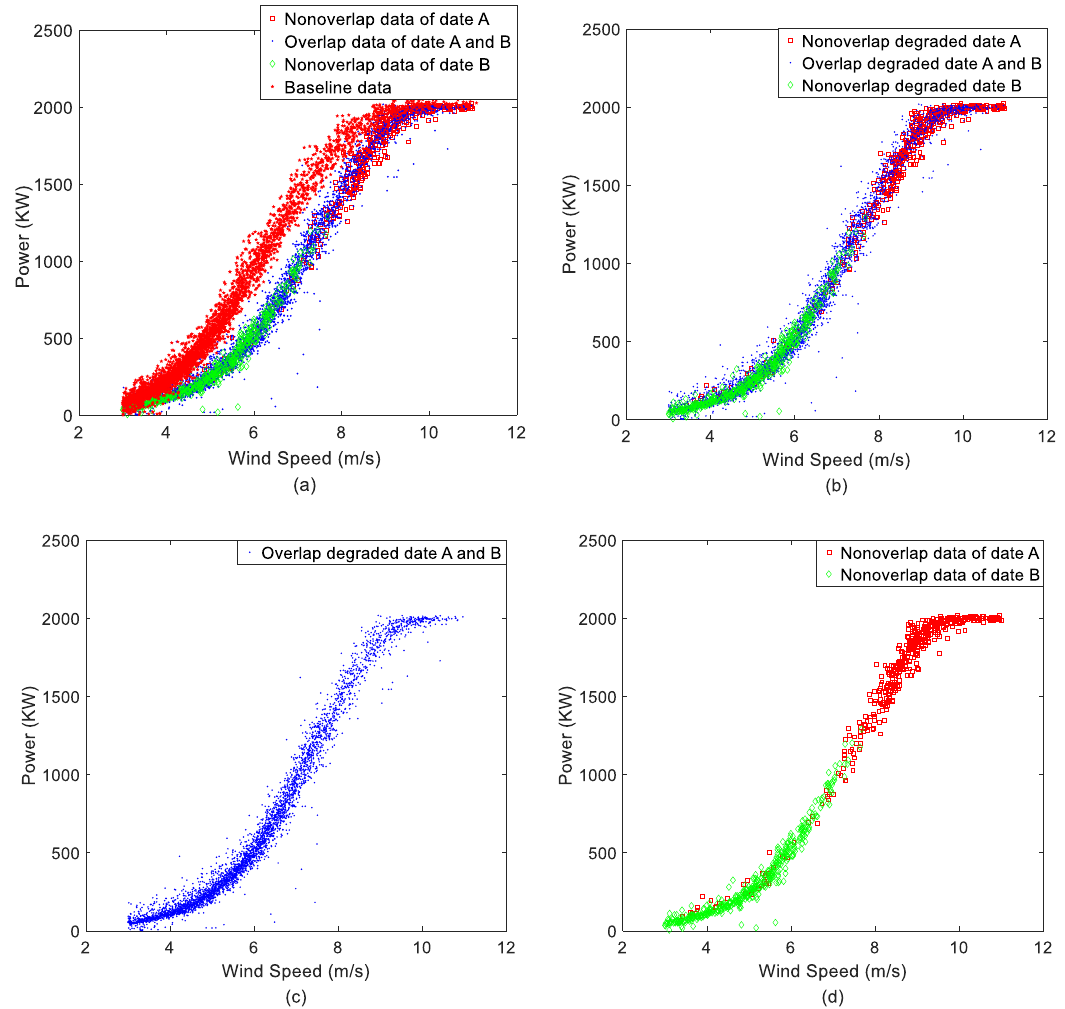
Figure 10. Comparative data analysis of Date A and Date B ( a ) Baseline data and data of date A and data B; ( b ) Data of date A and data B; ( c )Overlap data of date A and B; ( d ) Nonoverlap data of date A and B.